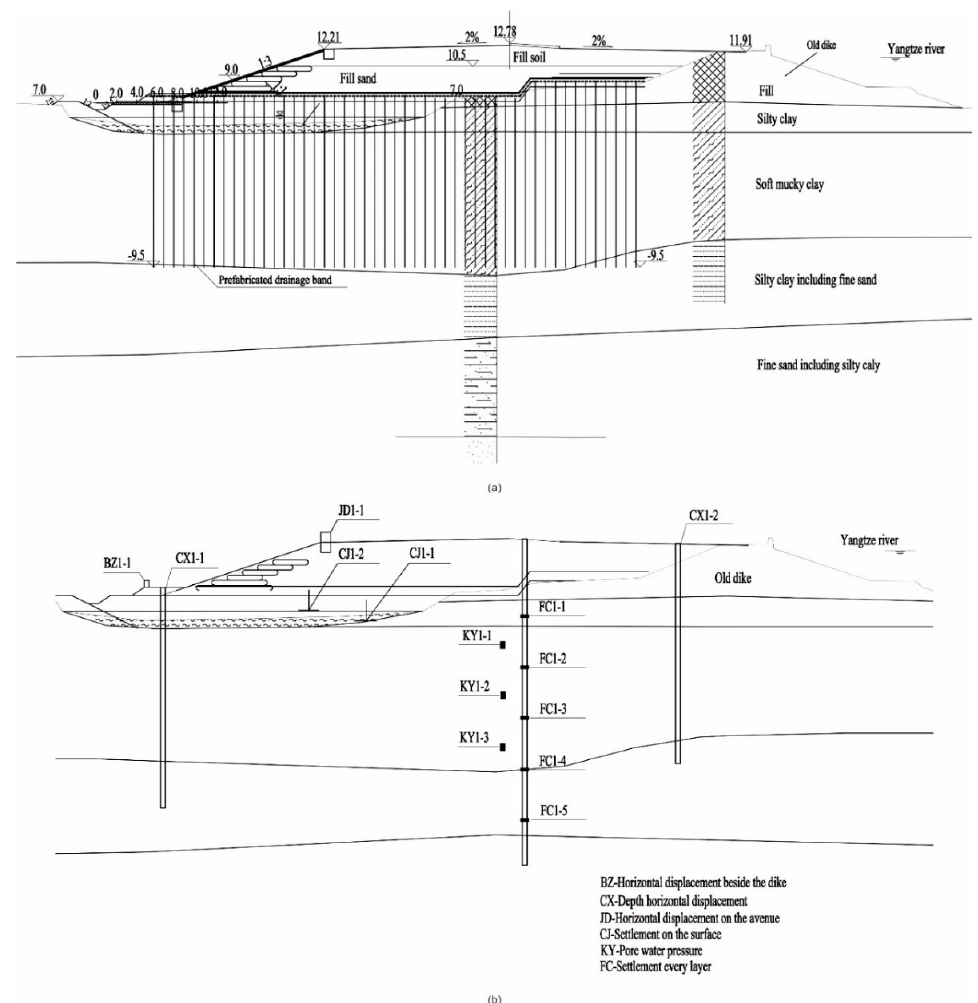
Figure 3. Monitoring section and layout of the monitoring instruments in the test zone: ( a ) Section K12 + 850; ( b ) Layout of the monitoring instruments.